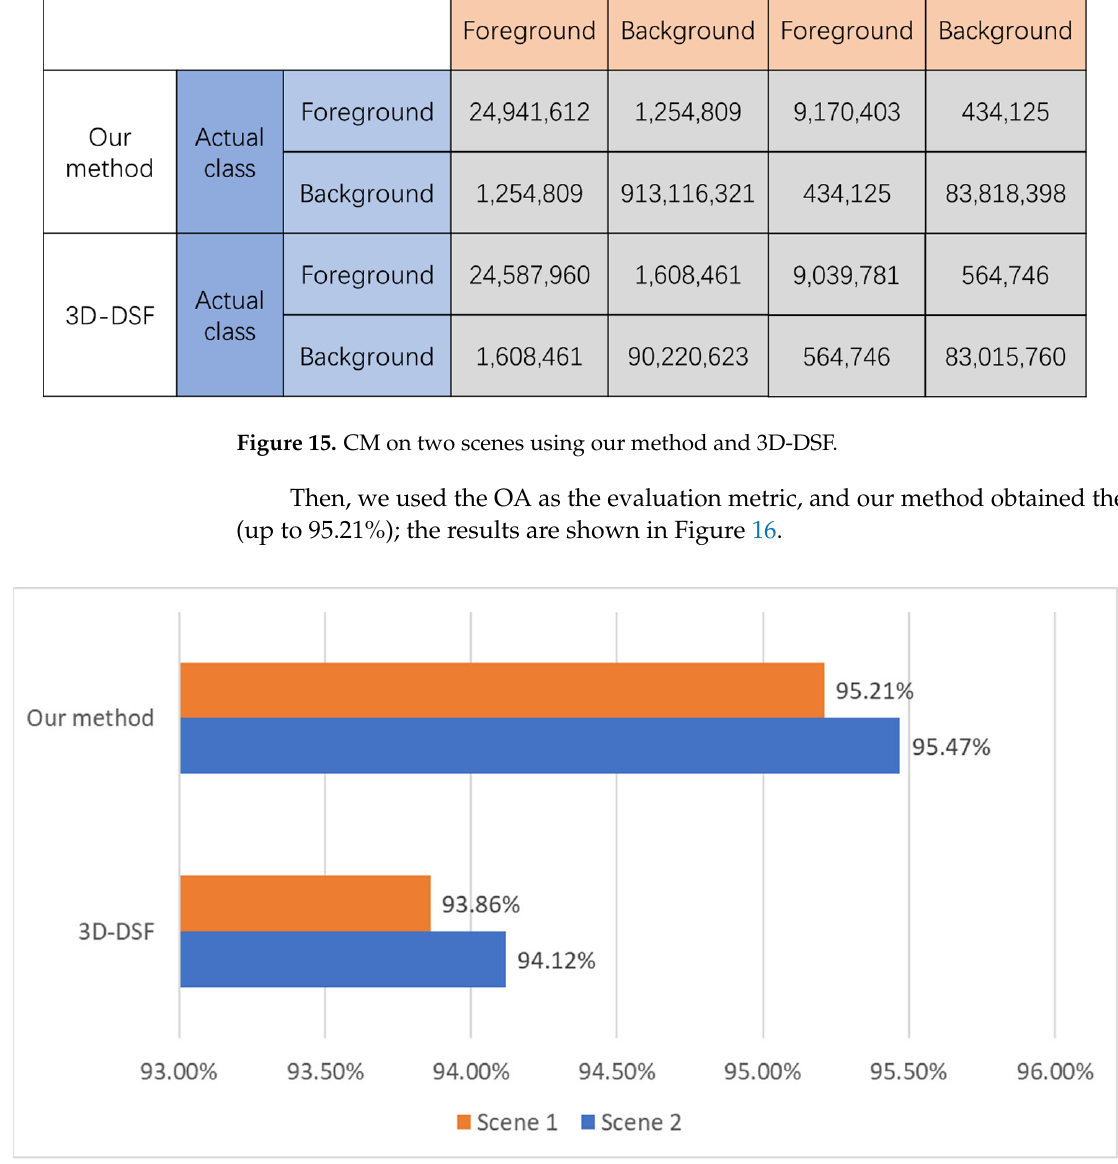
Figure 16. OA of the two scenes using our method and 3D ‐ DSF.